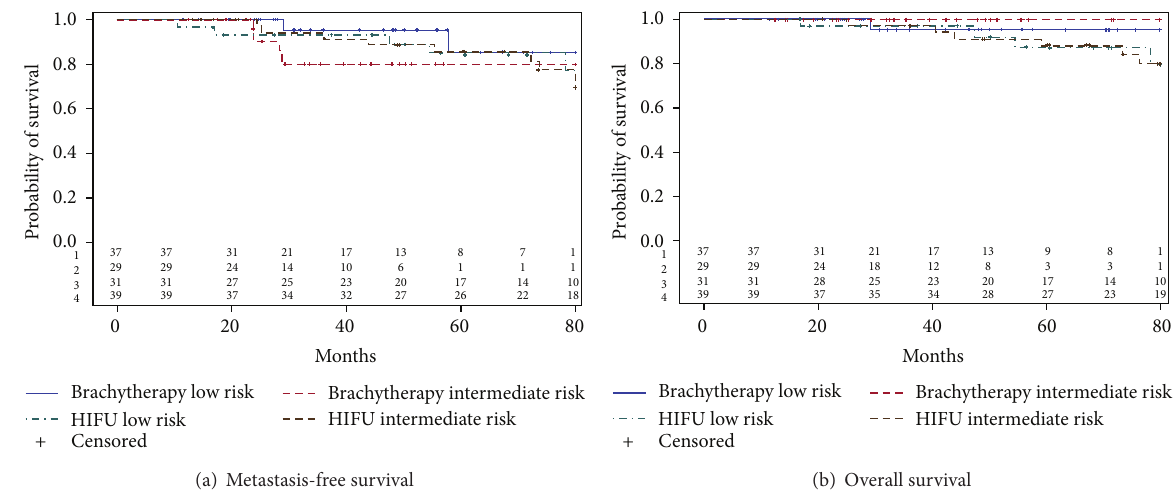
Figure 3: Kaplan-Meier curves for metastasis-free survival (a) and overall survival (b) stratified according to D’Amico risk classification.